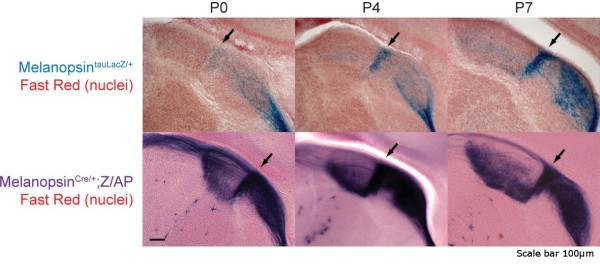
ipRGC innervation of the LGN. Comparison of LGN innervation by Opn4tauLacZ/+-labeled ipRGC axons and Opn4Cre/+;Z/AP labeling of total ipRGC axons across postnatal development. Arrows denote the intergeniculate leaflet, which separates the dorsal and ventral LGN. Scale bar: 100 μm.